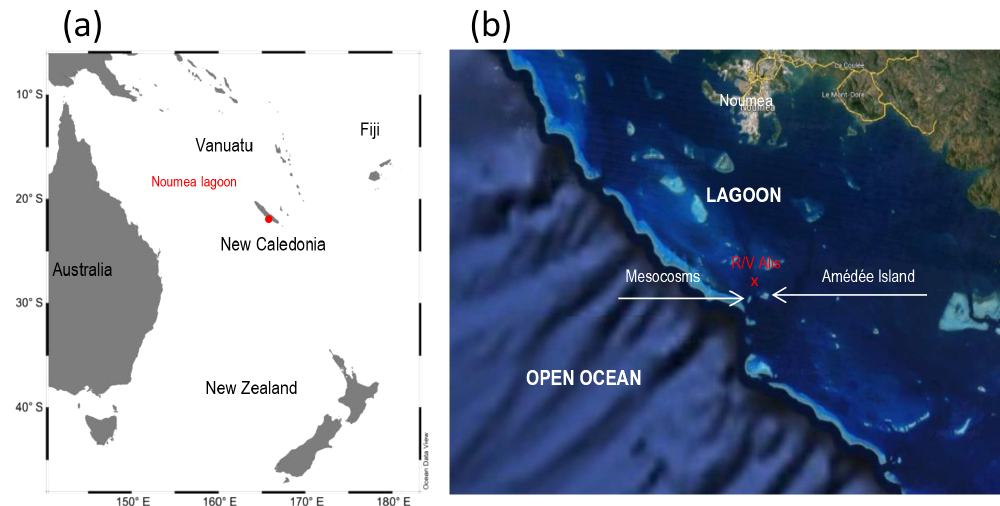
Figure 1. Study site of the VAHINE experiment. Location map of New Caledonia in the south-western Pacific (a) , Map of the Noumea lagoon showing the location of mesocosms at the entrance of the lagoon, 28 km off the coast (b)